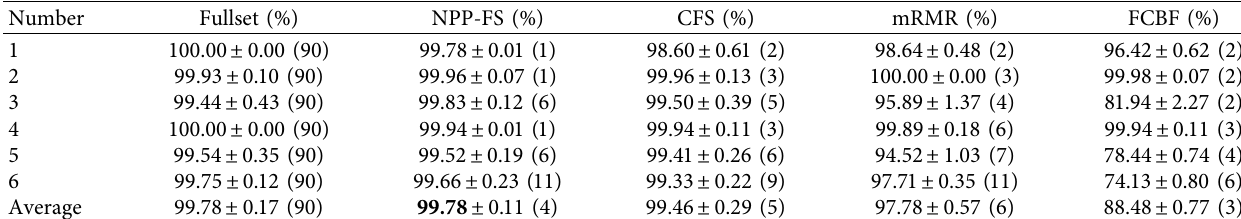
Table 6: Comparison of feature selection algorithms under KNN